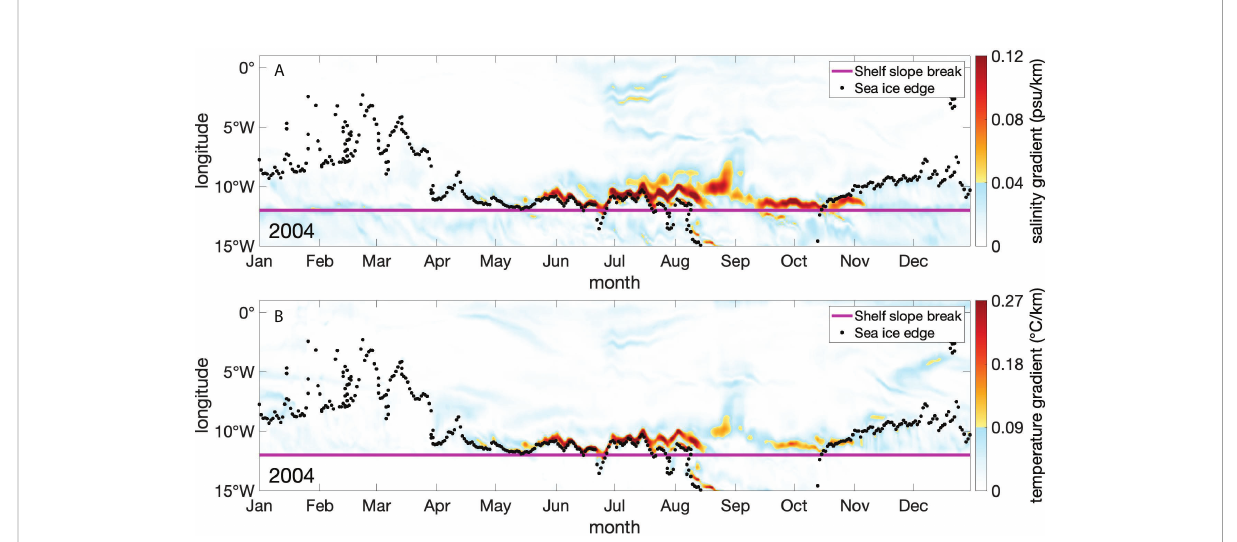
FIGURE 5 Daily variation of (A) sea surface salinity horizontal gradient and (B) sea surface temperature horizontal gradient (background color) along the section (red line) indicated in Figure 1A. The black dots are the daily variation of the intersections between the marginal ice line and the section line. The abscissa is the time for 2004, and the ordinate is the longitude of the section. The solid purple line is the position of the shelf break along the section